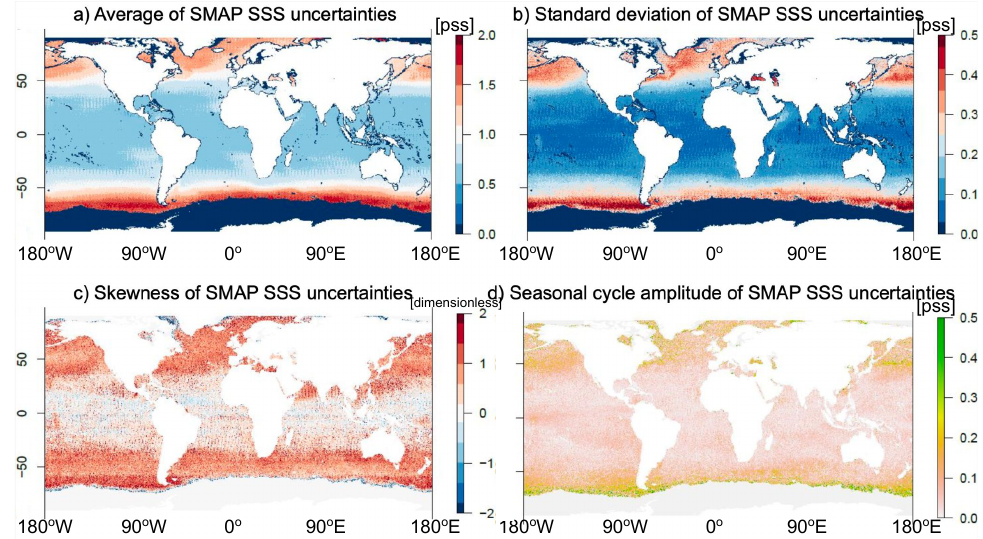
Figure 4. Statistics for SMAP Level-2 sea-surface salinity (SSS) product uncertainty for the period April 2015 to December 2020: ( a ) SSS uncertainty average, ( b ) SSS uncertainty standard deviation, ( c ) SSS uncertainty skewness, and ( d ) SSS uncertainty seasonal cycle amplitude. The standard deviation and skewness are computed after the removal of the seasonal cycle and trend. The maps synthesize the SMAP data without interpolation, but averages all data over each nearest 50 km by 50 km grid point and over each 8-day time